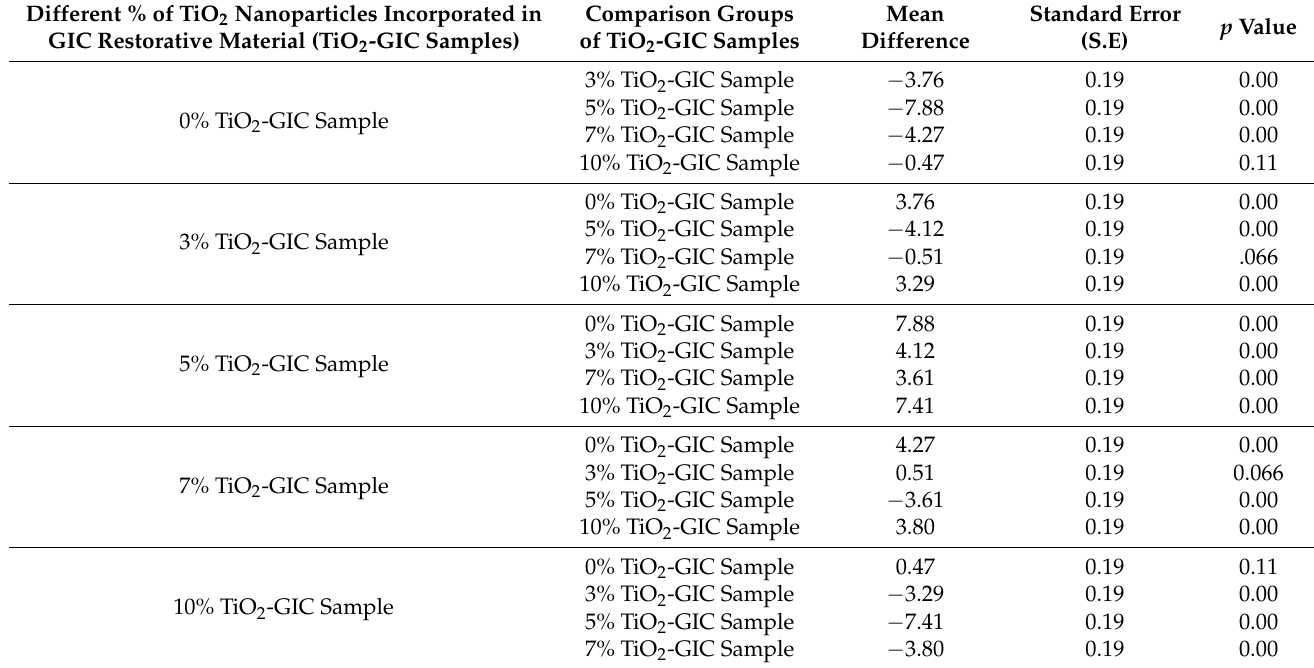
Figure 10. Compressive strength analysis of GIC restorative material containing various concentra- tions of TiO 2 nanoparticles. Table 3. Inter-group comparisons of compressive strength of GIC restorative material containing various concentrations of TiO 2 nanoparticles.